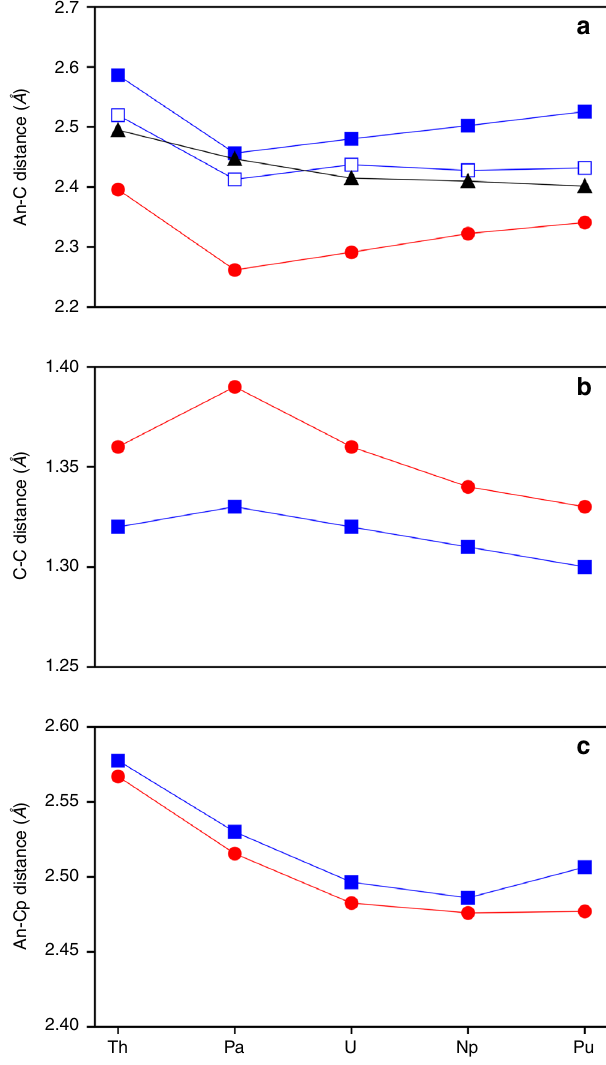
Fig. 3 Selected geometric distances in propene and cumulene